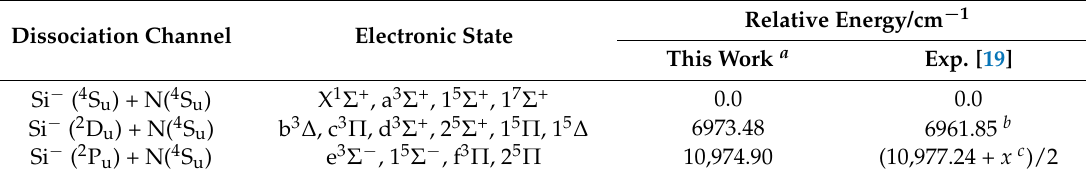
Table 1. Dissociation relationships of the 14 states generated from the first three dissociation channels of the SiN −